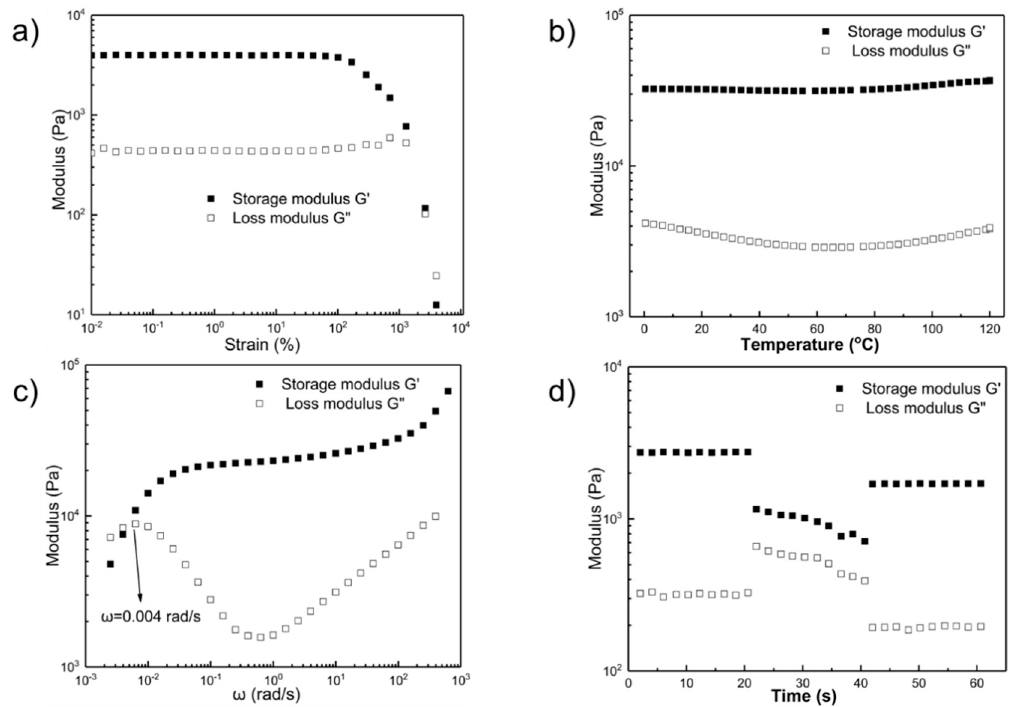
Figure 2. ( a ) Oscillatory strain sweeps of TFPM-PDMS-25000 at different temperatures. ( b ) Dynamic oscillatory temperature sweeps of TFPM-PDMS-25000 ranging from 0 °C to 120 °C at 1 Hz. ( c ) Frequency sweeps of TFPM-PDMS-25000 ranging from 0.001 rad/s to 628 rad/s with 0.1% strain amplitude at room temperature. ( d ) Continuous step strain measurements of TFPM-PDMS-25000 at 25 °C and 1 Hz, under a small strain amplitude 0.1% or a large strain amplitude 1000%.